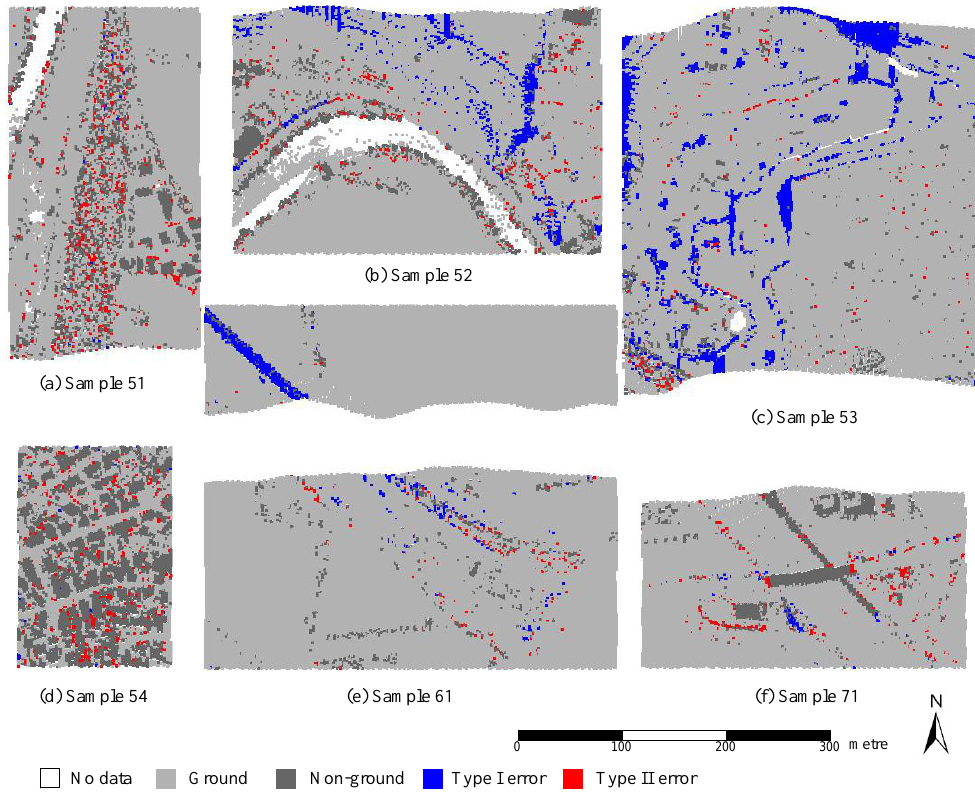
Figure 12. Error distribution of filtering rural samples 51–71 of ISPRS data.